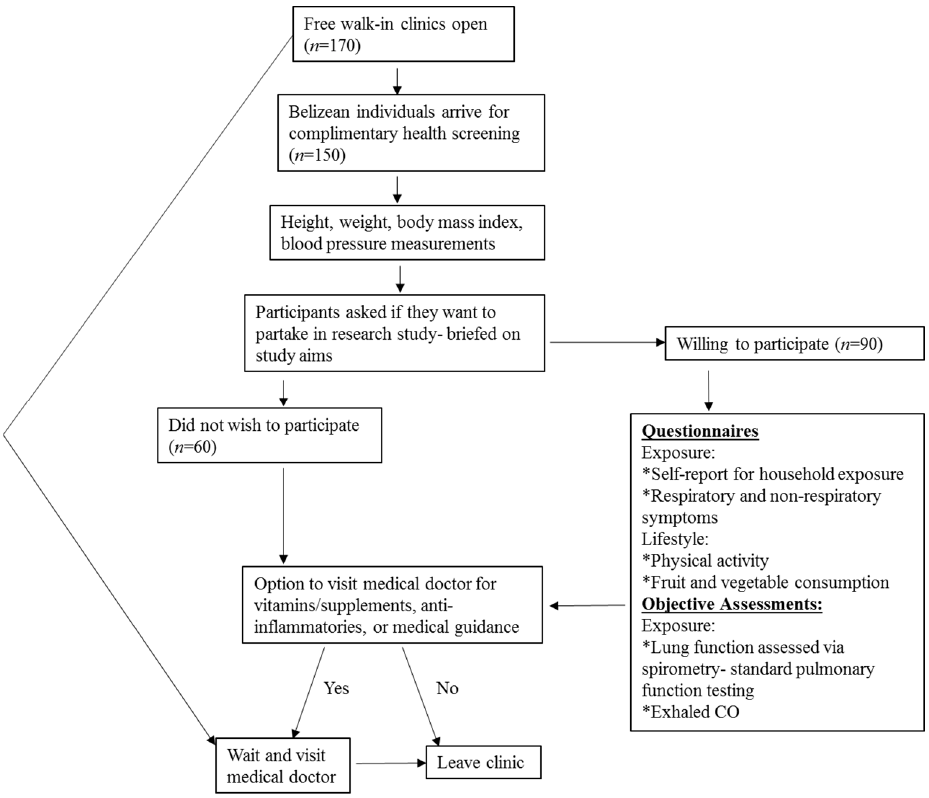
Figure 1. Schematic of the study design at the free walk-in clinics.